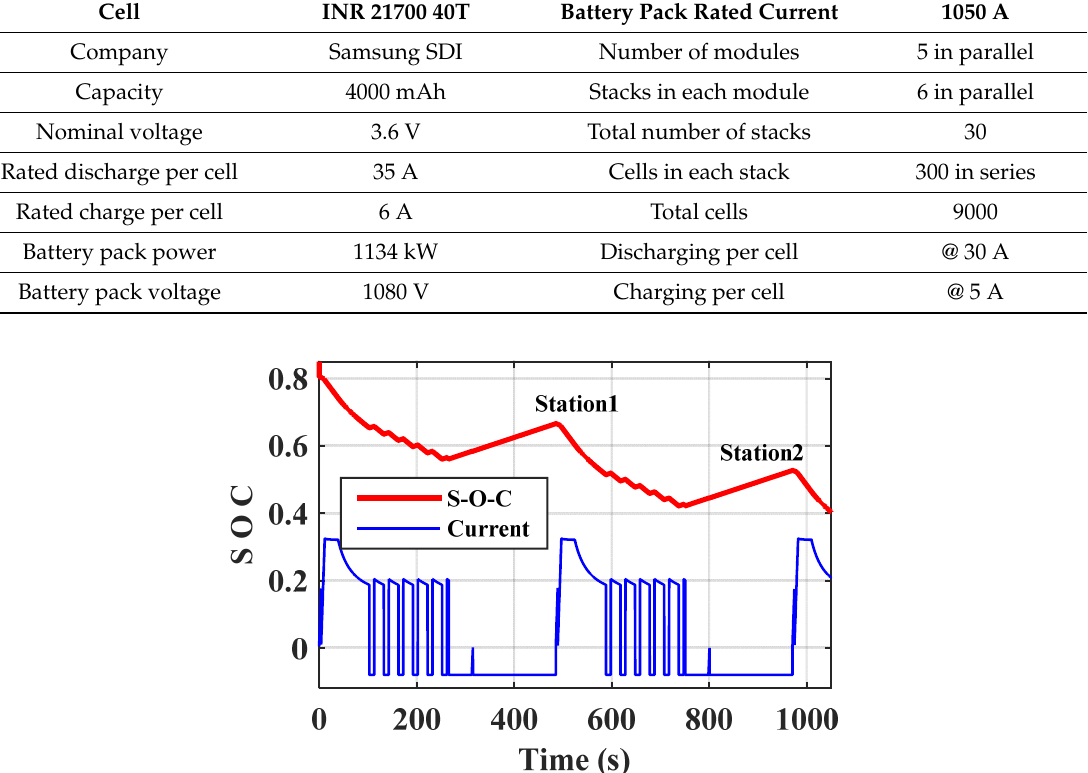
Figure 15. Regenerative power capture by batteries of different sizing ( a ). Rated for maximum load ( b ) Rated for five times of maximum load. Figure 16. Battery pack’s state of charge with actual load profile scaled (sized for five times of maximum load).